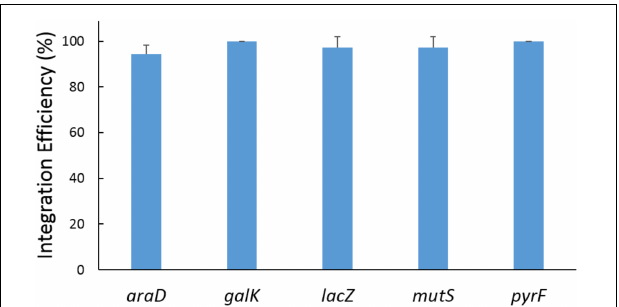
FIGURE 4 | Results of recombination at a single locus. The five loci were edited in five independent experiments. In each experiment, a single locus among the five loci was edited. The donor plasmids pTc-A2, pTc-G, pTc-L, pTc-M, and pTc-P provided donor DNA and crRNAs for the araD , galK , lacZ , mutS, and pyrF site, respectively. The helper plasmid p46Cpf1-OP2 was used. The data represent the averages of three independent experiments.